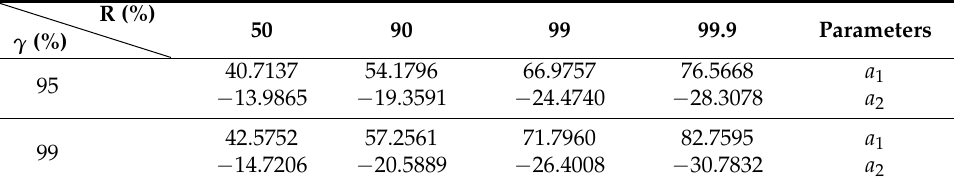
Table 5. Parameters of P-S-N with R a = 0.8 μ m.